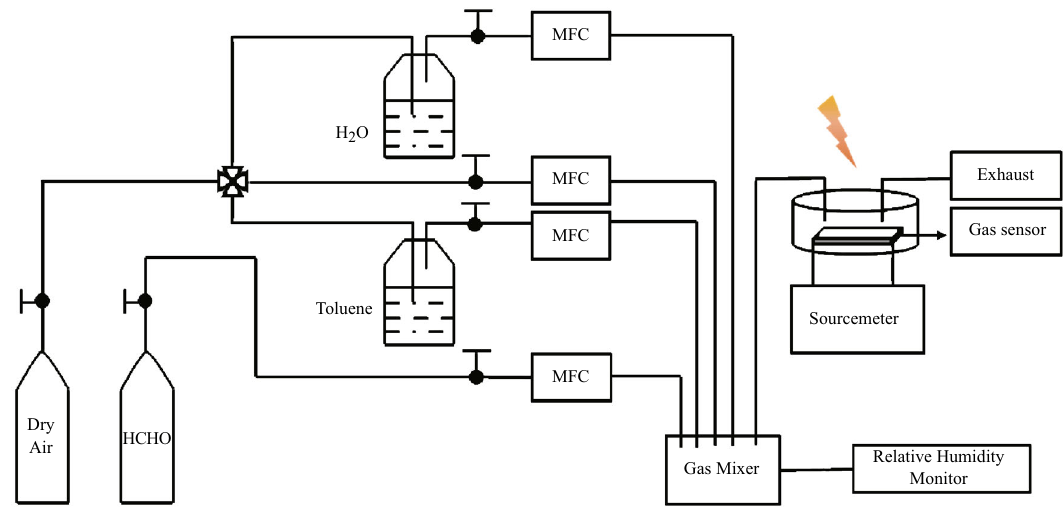
Fig. 4 Experimental setup for